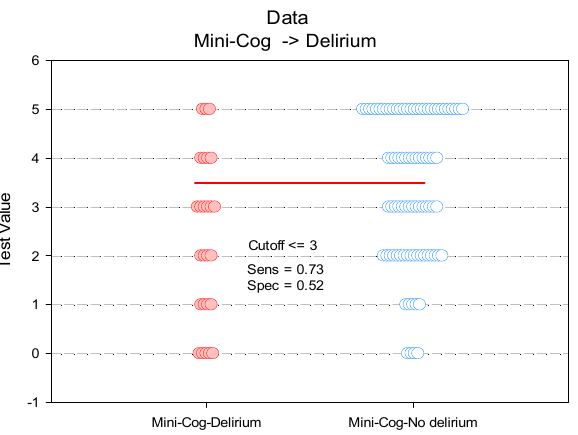
Figure 4. Paired histogram for estimating the cut-off value of the Mini-Cog score on predictability on POD. Table 3. Sensitivity and specificity of Mini-Cog test in predicting postoperative delirium.